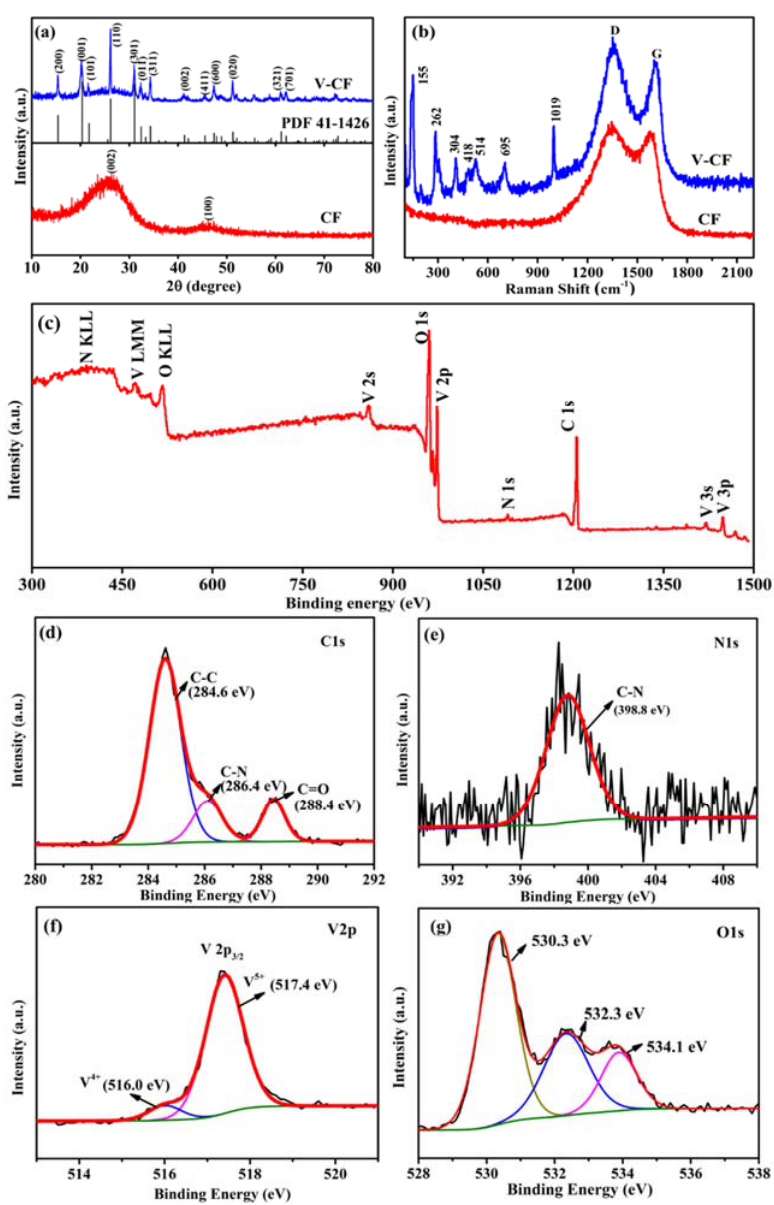
Figure 2. XRD patterns ( a ) and Raman spectra ( b ) of the carbon nanofiber (CF) and the V ‐ CF. XPS wide ‐ range survey spectrum ( c ) and the high ‐ resolution XPS spectra of C 1s ( d ), V 2p ( e ), N 1s ( f ), and O 1s ( g ) for the sample of V ‐ CF.